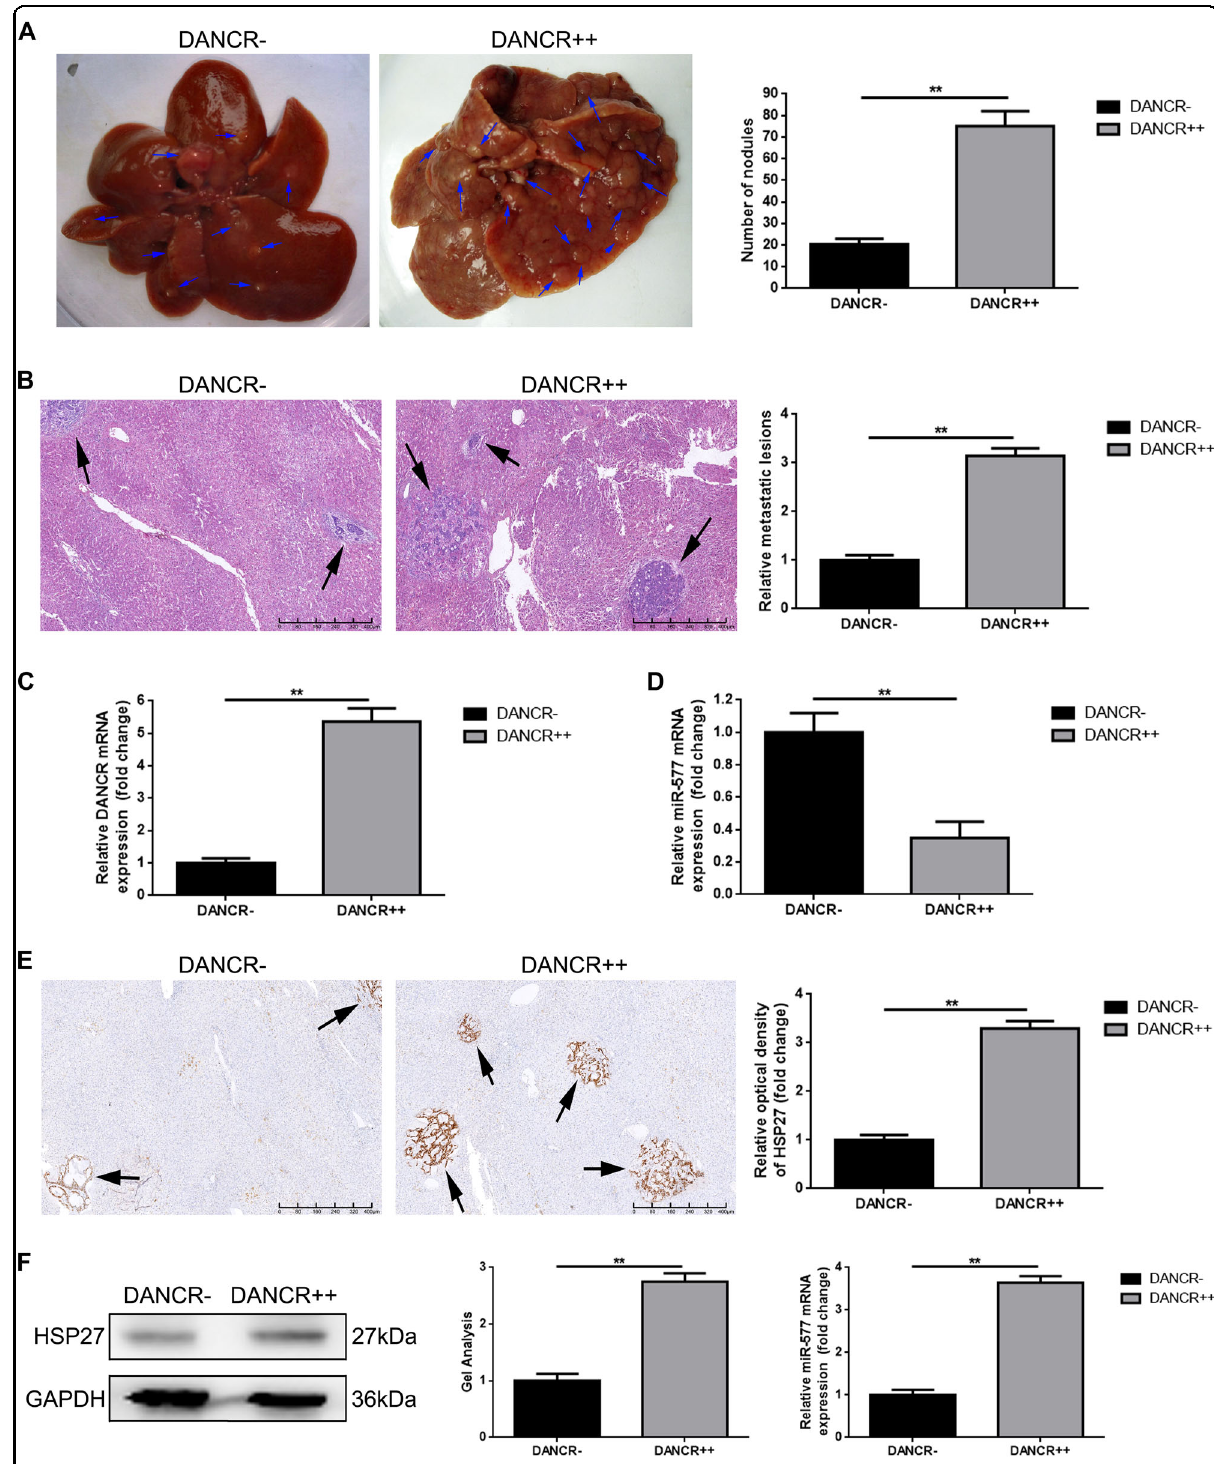
Fig. 8 Up-regulation of DANCR promotes the liver metastasis of CRC in vivo. a Representative photos of the metastatic nodules in the livers are shown. b H&E staining of the livers with metastatic nodules are shown. Scale bars = 400 µm; magni fi cation, ×40. c DANCR expression in the metastatic nodules was assessed by qRT-PCR. d miR-577 expression in the metastatic nodules was also assessed by qRT-PCR. e The expression level of HSP27 in the formatted tumors was evaluated by IHC (Scale bar = 400 µm; magni fi cation, ×40) and qRT-PCR. f HSP27 in the formatted tumors was evaluated by western blotting. ** P < 0.01 vs. the DANCR- group. The data are shown as the means ± SD from three independent